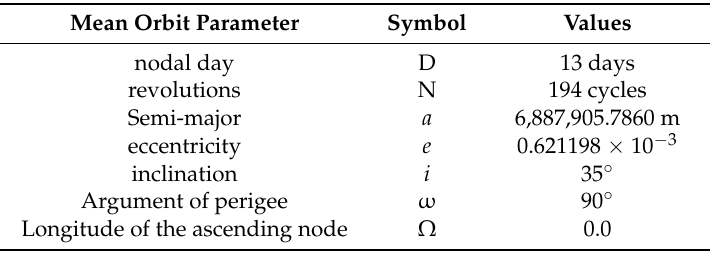
Table 2. Orbit parameters of the GNSS-R LEO